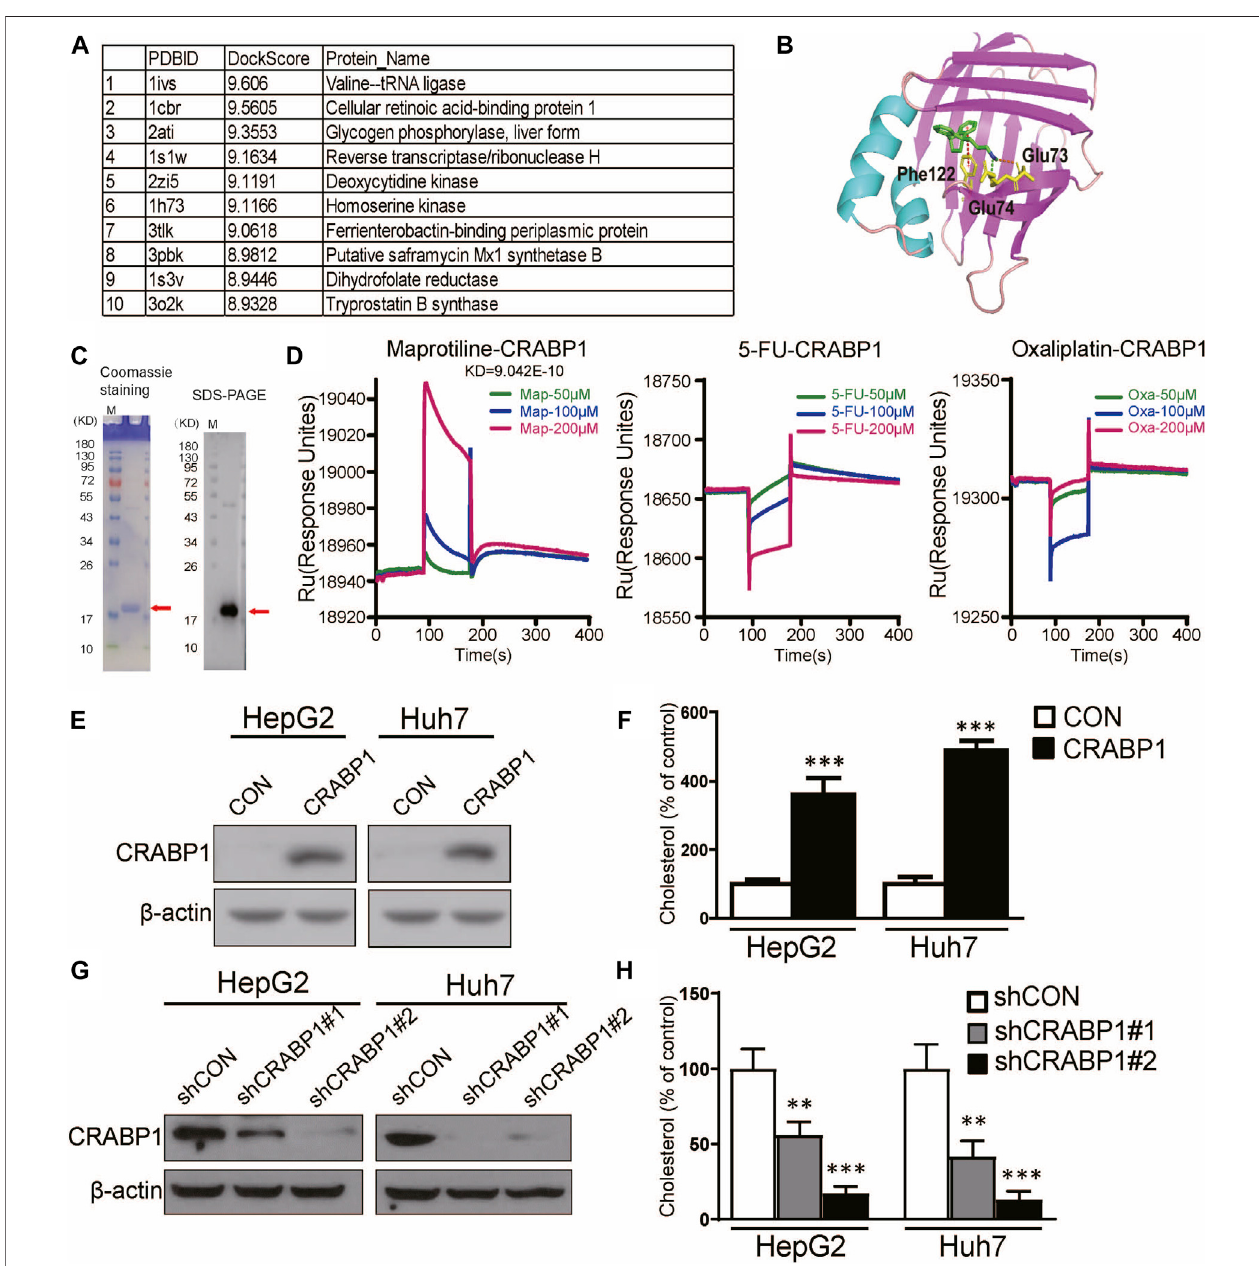
FIGURE 5 | Maprotiline directly targets CRABP1 in HCC cells. (A) Top 10 molecular docking scores. (B) Molecular docking of maprotiline and CRABP1. (C) CoomassiestainingandWesternblotofpuri fi edCRABP1protein;theredarrowindicatestheCRABP1band. (D) SPRanalysisrevealedthebindingbetweenmaprotiline and the CRABP1 protein. 5-FU and oxaliplatin were used as negative controls. (E) The overexpression of CRABP1 in HCC cells. (F) The relative cholesterol level of the CRABP1-overexpressing HCC cells. (G) The knockdown of CRABP1 in HCC cells. (H) The relative cholesterol level of the CRABP1 knockdown HCC cells.